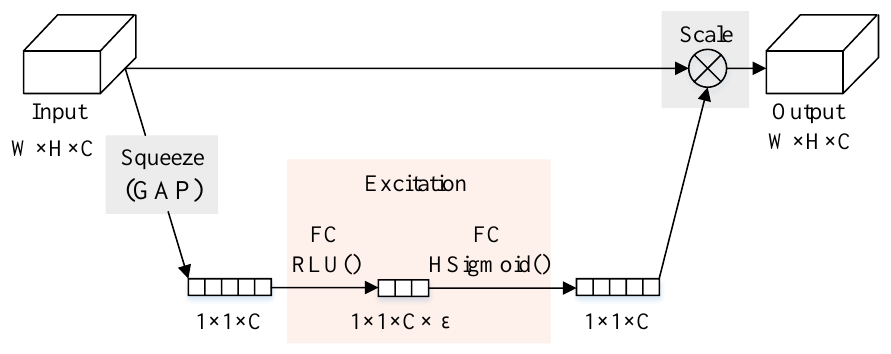
Figure 2. Structure of SE